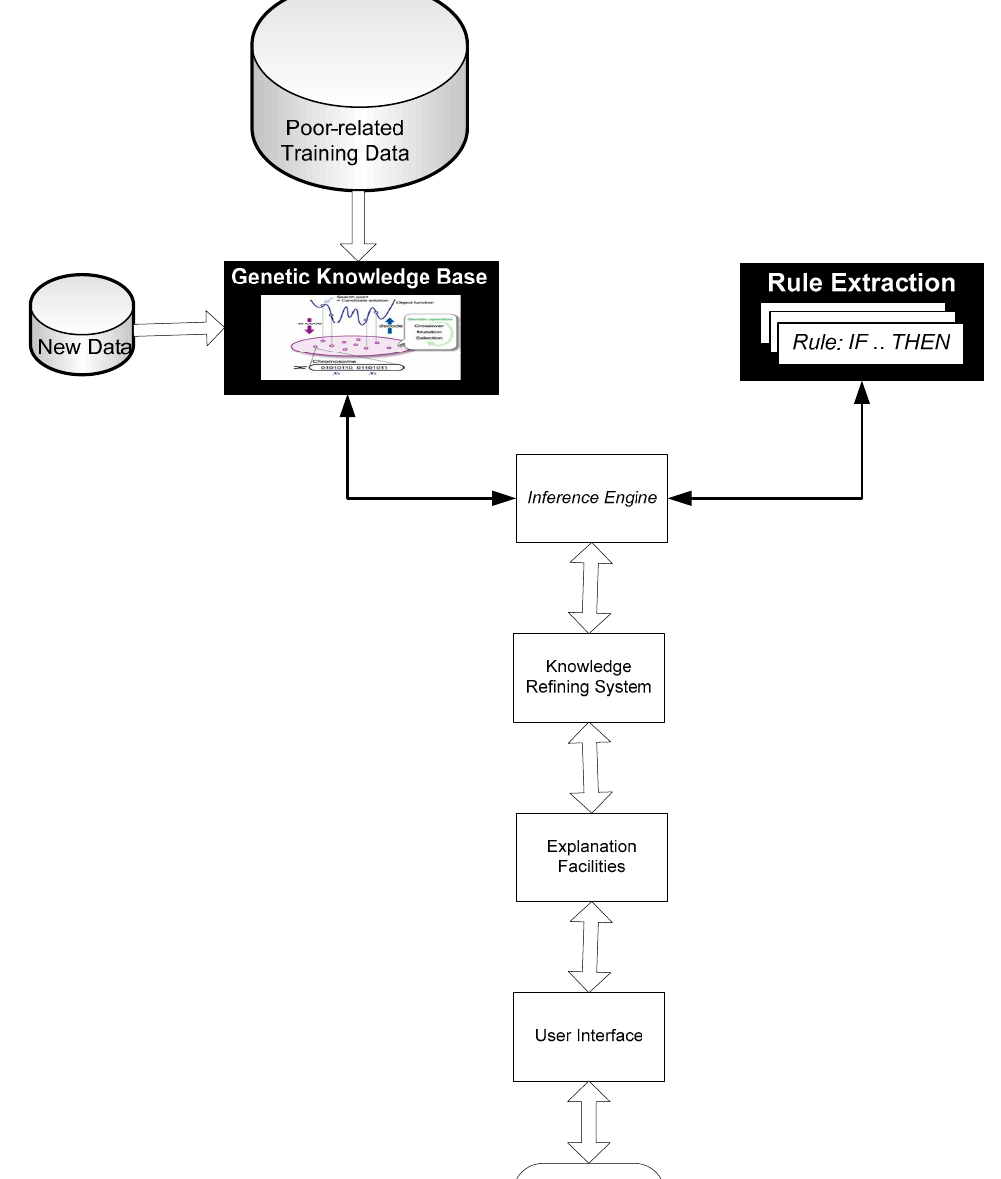
Figure 2. The Social Safety Net Expert System (SSNES).